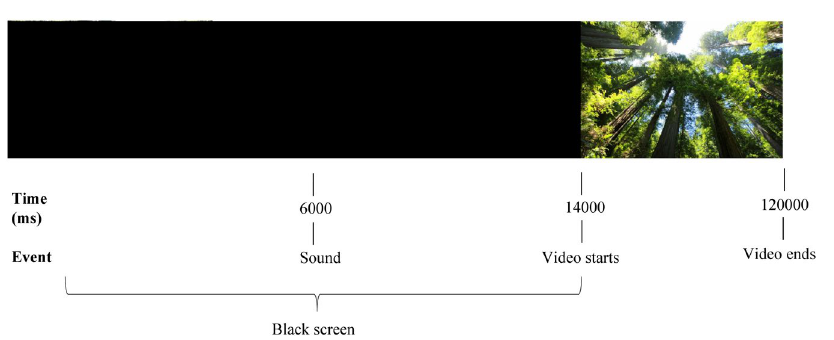
Figure 3. The sequence of video subsections. Image of Tall trees was taken from Pixabay (credits: Pixabay,